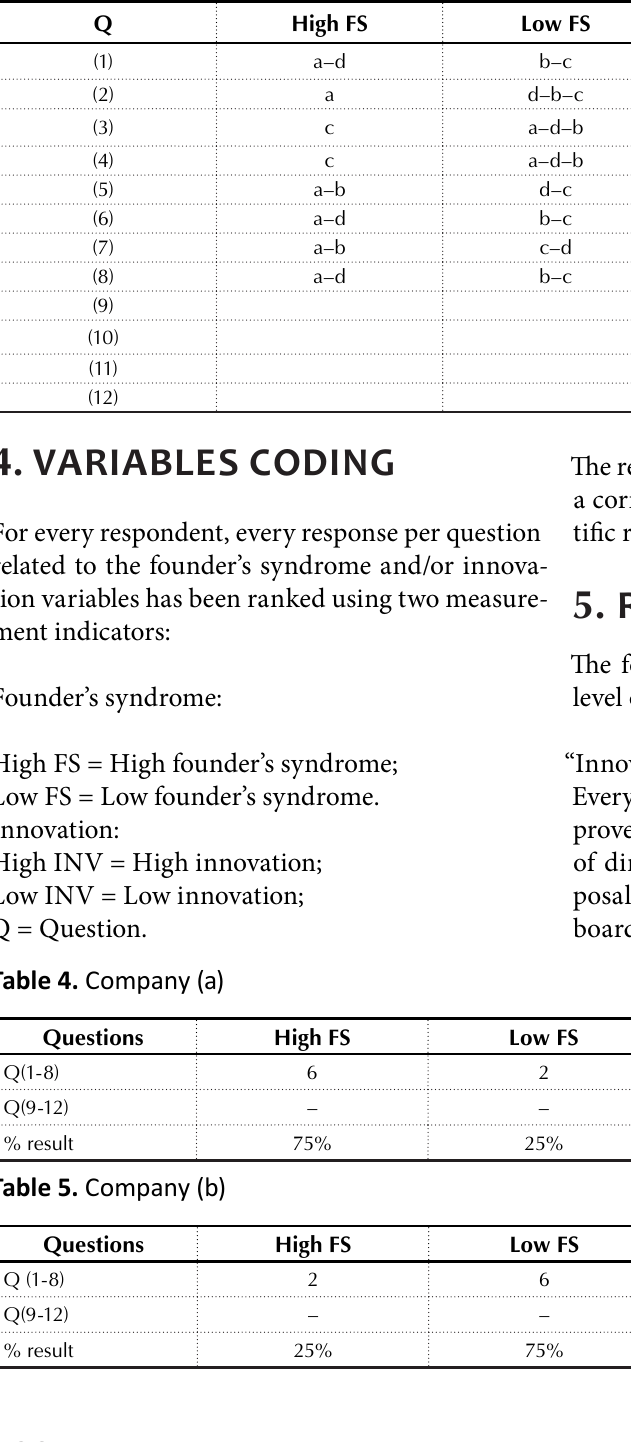
Table 3. Results of comparative & correlation analysis